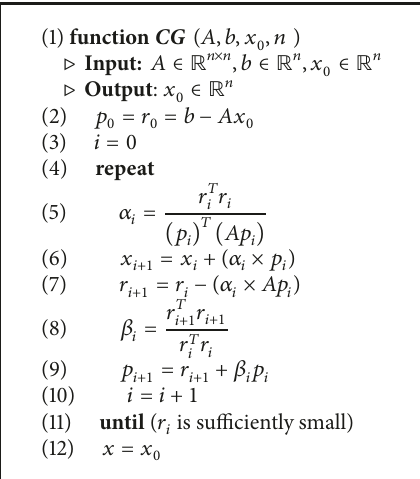
Algorithm 1: Conjugate gradient algorithm.